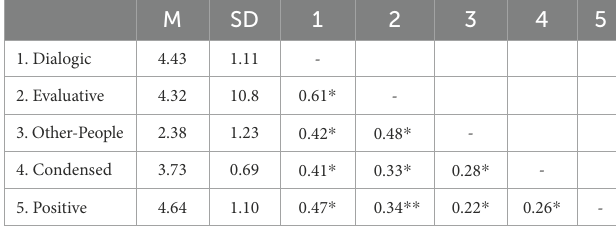
TABLE 1 Inter-correlations of the VISQ-R subscale-scores ( n =